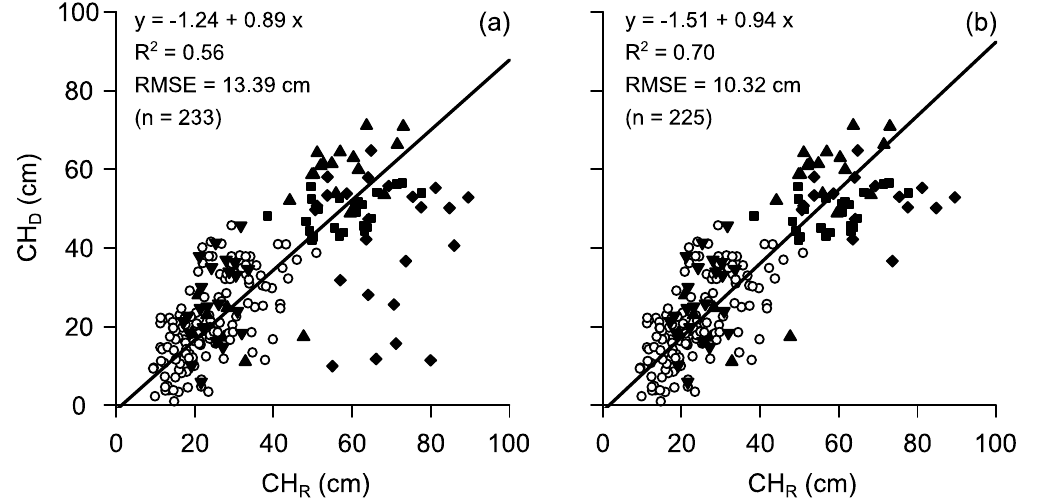
Figure 4. Linear relationship between canopy height from manual height measurements (CH R ) and UAV-based RGB imaging (CH D ) for the whole dataset ( a ) and for the whole dataset excluding pure grass stands of the second cut ( b ). The different symbols indicate sub-samples ( ), which were taken between the first ( (cid:4) ), second ( (cid:7) ), third ( (cid:78) ) and fourth ( (cid:72) ) harvest.